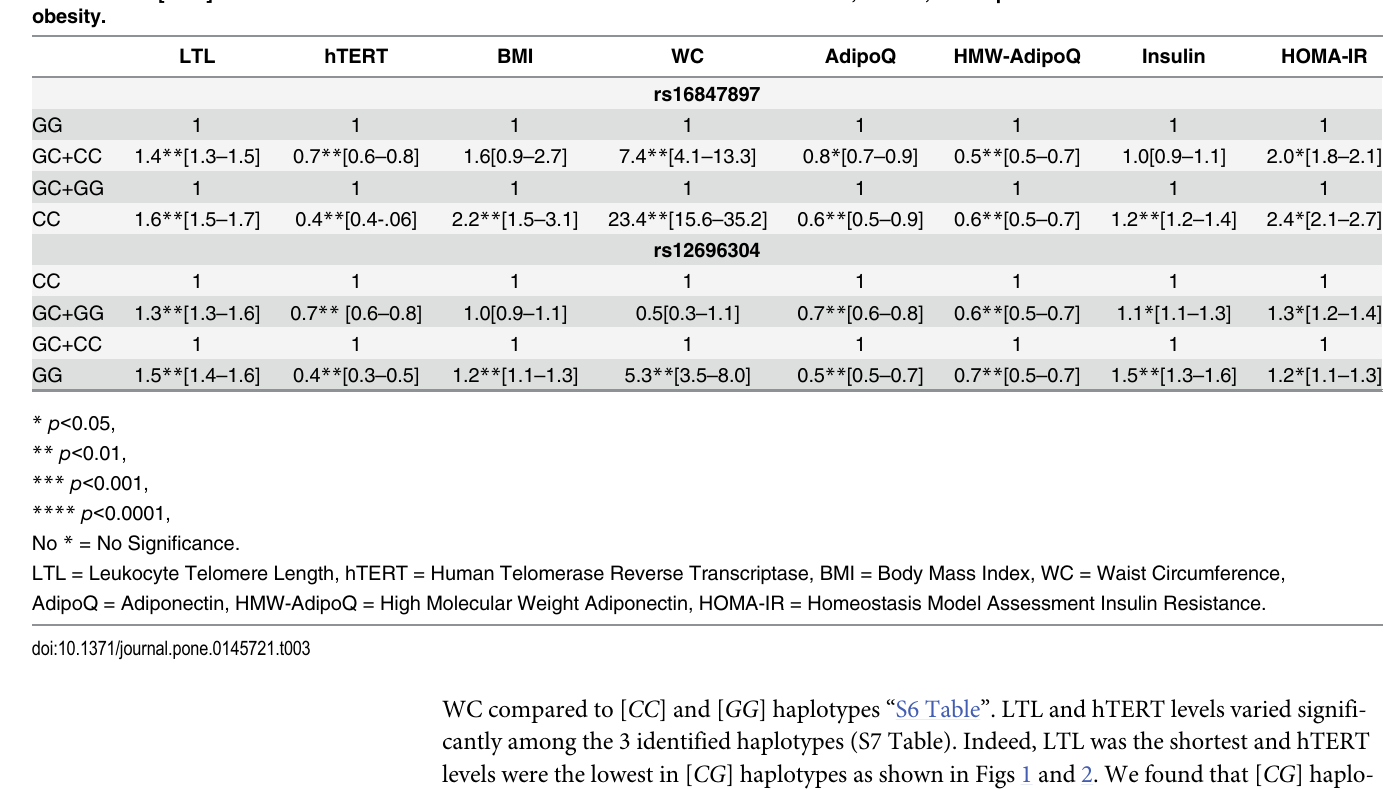
WC compared to [ CC ] and [ GG ] haplotypes “ S6 Table ” . LTL and hTERT levels varied signifi- cantly among the 3 identified haplotypes (S7 Table). Indeed, LTL was the shortest and hTERT levels were the lowest in [ CG ] haplotypes as shown in Figs 1 and 2. We found that [ CG ] haplo- type was significantly associated with higher risk of shorter LTL and lower telomerase levels